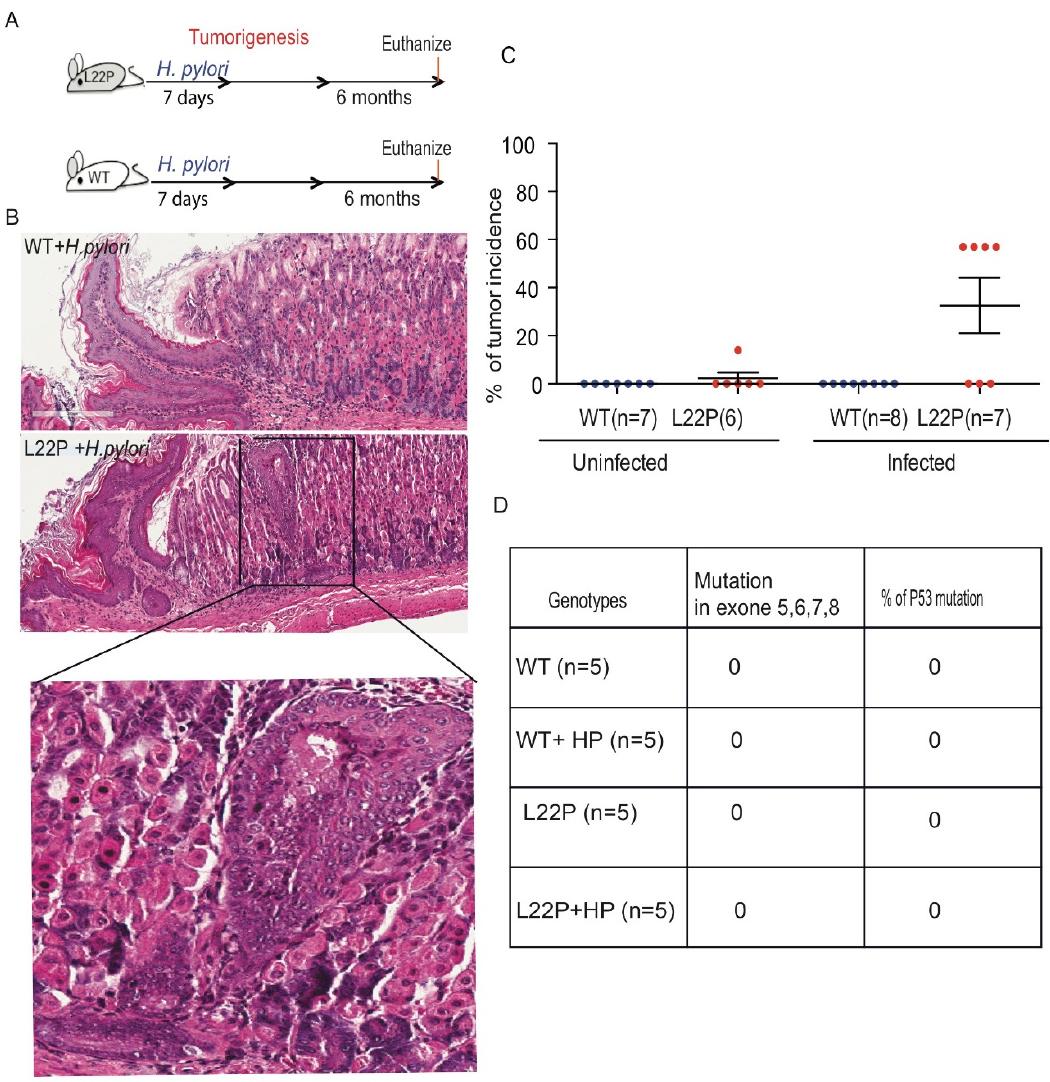
Figure 4. H. pylori infection increases tumor incidence and latency in POLB mutated mouse model. ( A ) Schematic representation of H. pylori mediated carcinogenesis study conducted for 3 months and 6 months after treatment with H. pylori ; Five to eight weeks old WT and L22P mice were infected with H. pylori and evaluated for bacteria colonization after 7 days of infection and magnitude of inflammation was evaluated after 3 months of infection and all mice were terminated at 6 months of infection. ( B ) H and E staining of WT and L22P mice infected with H. pylori ; image shows magnified (40x) pathological lesions of the inflammation on L22P gastric gland regions; ( C ) Estimated tumor incidence in WT and L22P with and without H. pylori infection after 6 months; ( D ) Percent of WT and L22P mice with p53 mutation in exon 5, 6, 7 and 8 with or without H. pylori